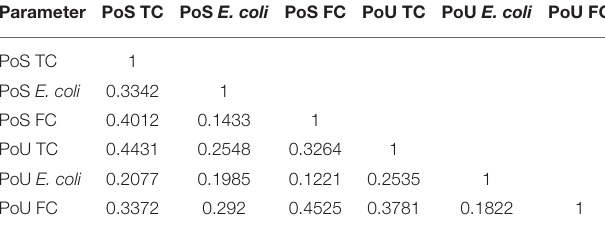
TABLE 4 | Pearson correlations among different coliform bacteria at PoS and corresponding PoU (Obs 260 in both